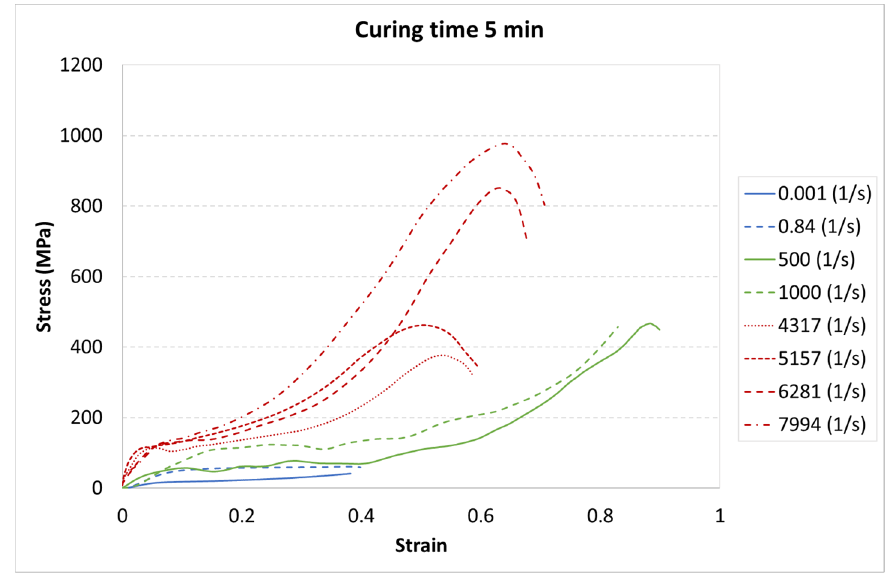
Figure 6. Results of durable resin tested under various strain rates for a curing time of 5 min for ultraviolet (UV) and heat exposure.